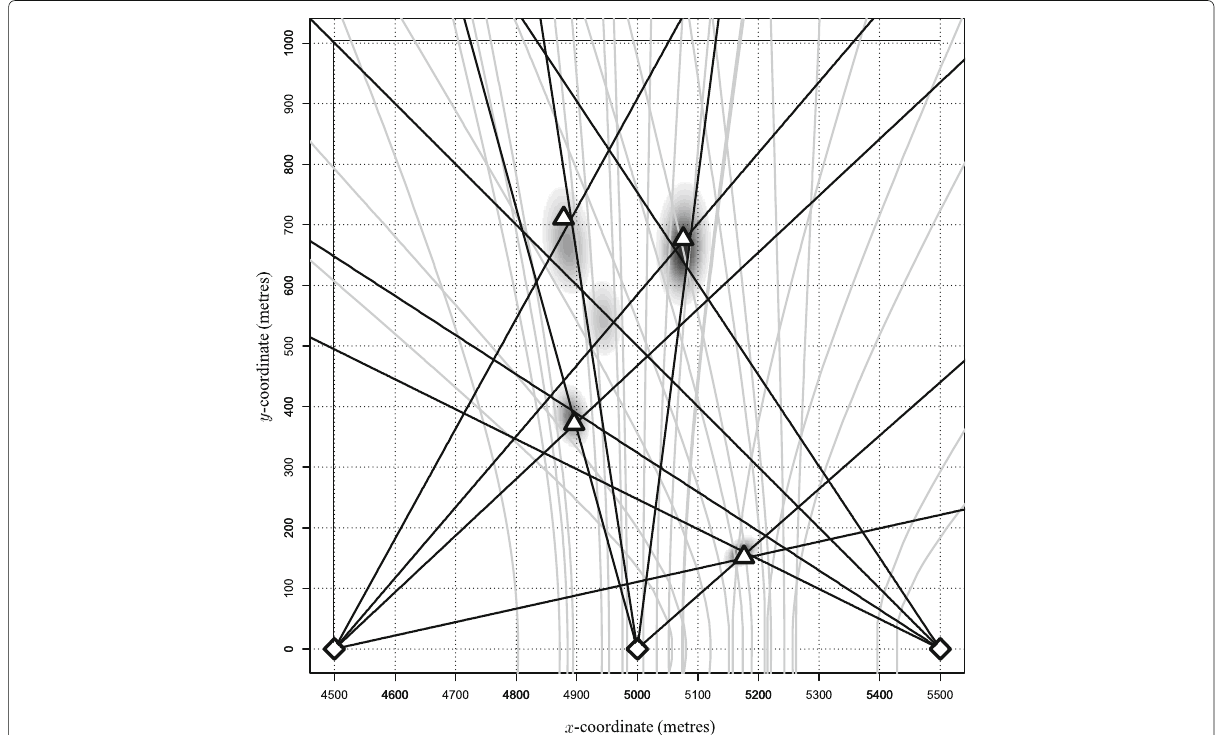
Fig. 1 An exemplar scenario with four target events and three sensors that provide hybrid AOA/TOA measurements. Shown are target events (marked by triangles ) and the sensors (marked by diamonds ); along with AOA measurements ( blacklines ) and DDOA measurement hyperbolae ( grey lines ). Also shown is the likelihood map, with darkregions showing a normalised overall measurement likelihood close to unity, and whiteregions showing a normalised overall measurement likelihood close to zero. It is noted that this likelihood map is not calculated by the TALA and is shown for illustrative purposes